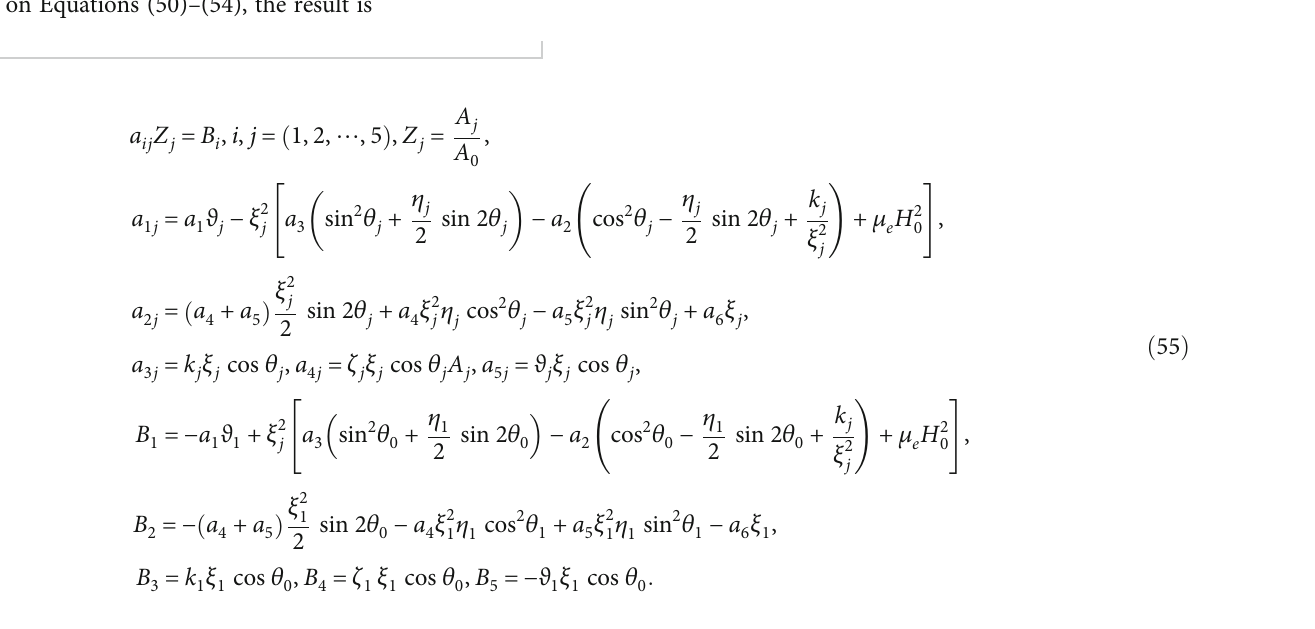
Figure 1 highlights the various values of the amplitudes j concerning the angle of incidence of the re fl ected j z 1 waves θ for various values of the fractional parameter of two di ff erent values of gravity g . Clearly, the amplitudes of incidence waves j z 1 j decline when rising the gravity fi eld. They decline then rise with the increase of θ to reach the unit at θ = 90 ° .